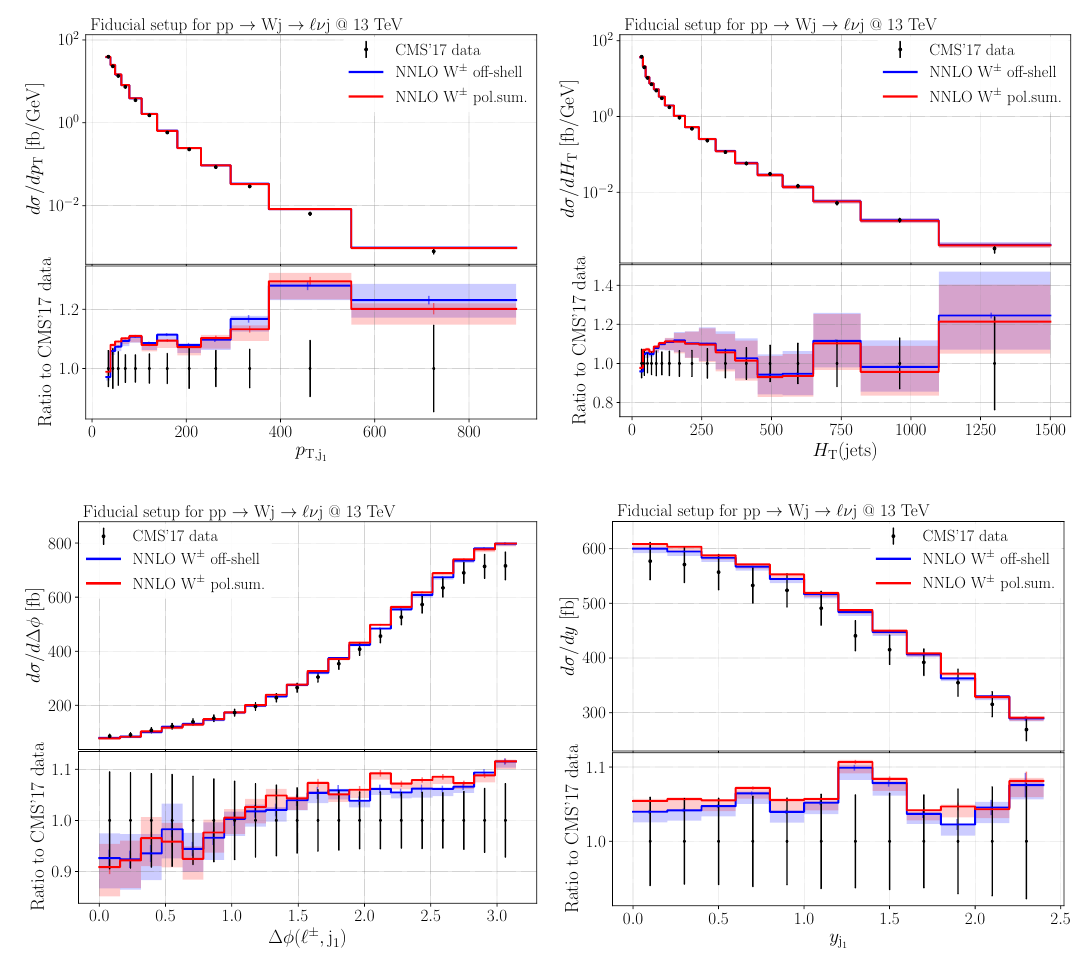
Figure 13 . Differential distributions for pp → ‘ ± ( − ) ν ‘ j in the fiducial setup: transverse momentum of the hardest jet (top left), transverse energy of jets (top right), azimuthal angle between the charged lepton and the hardest jet (bottom left), and rapidity of the hardest jet (bottom right). The upper pane features absolute predictions at NNLO for the polarised sum in the NWA and the off-shell setup. The data points are taken from ref. [27]. The lower pane shows the same predictions normalised to the experimental data. The bands represent scale variation